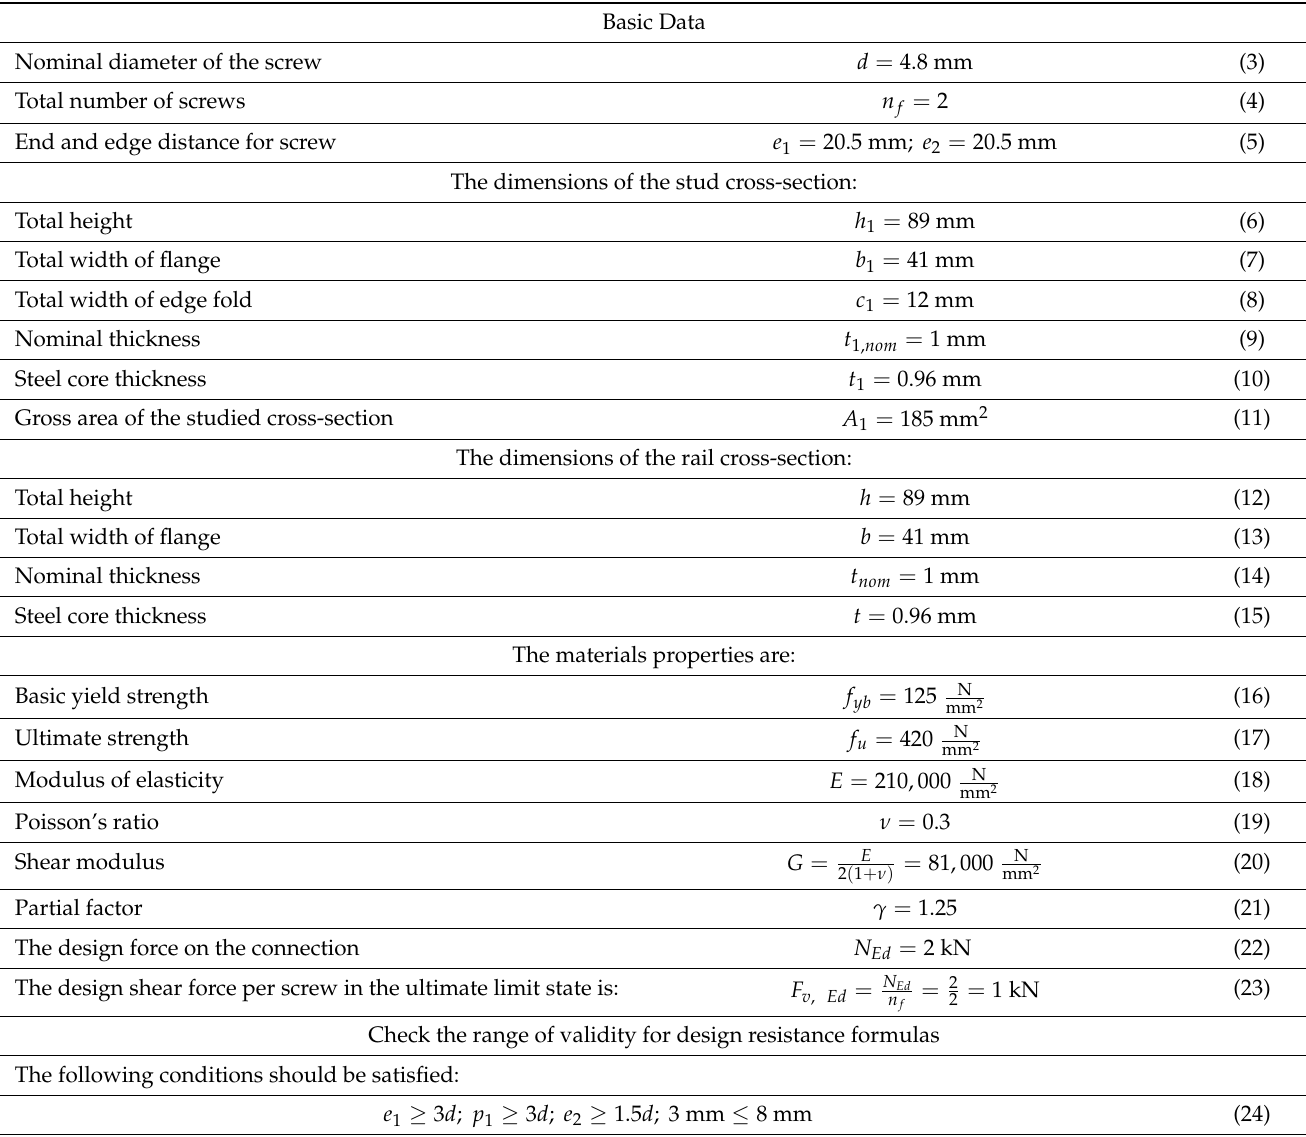
Table 2. Joint A design according to EN